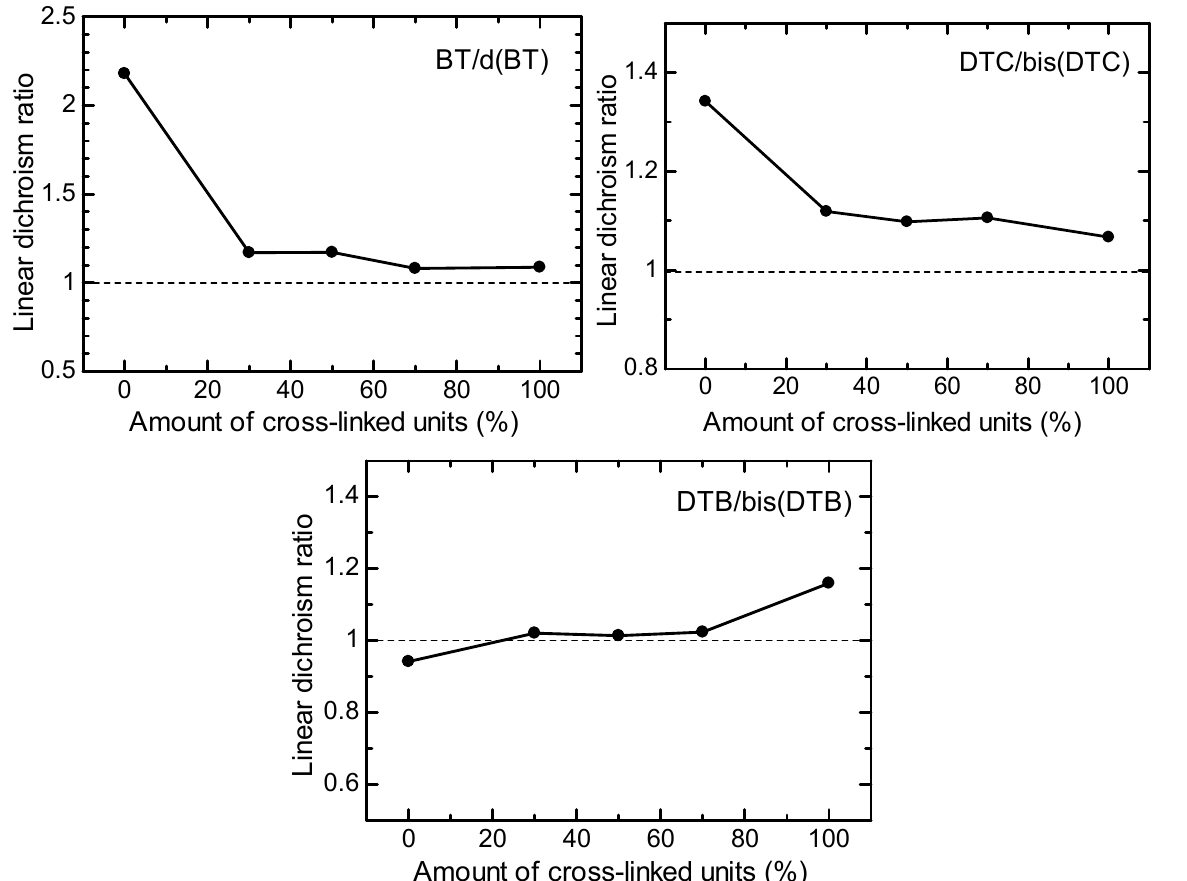
Figure 5. LDR of polymer films obtained from the BT/d(BT) group, DTC/bis(DTC) group, and DTB/bis(DTB) group with different RCUs. LDR: Linear dichroism ratio. RCU: Ratio of crosslinked units.